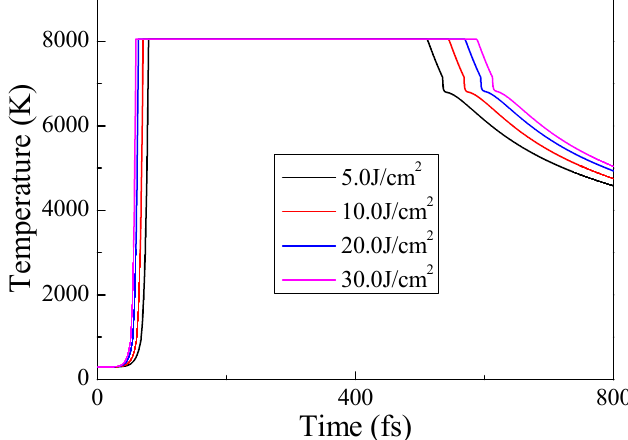
Energies 2018 , 11 , x FOR PEER REVIEW